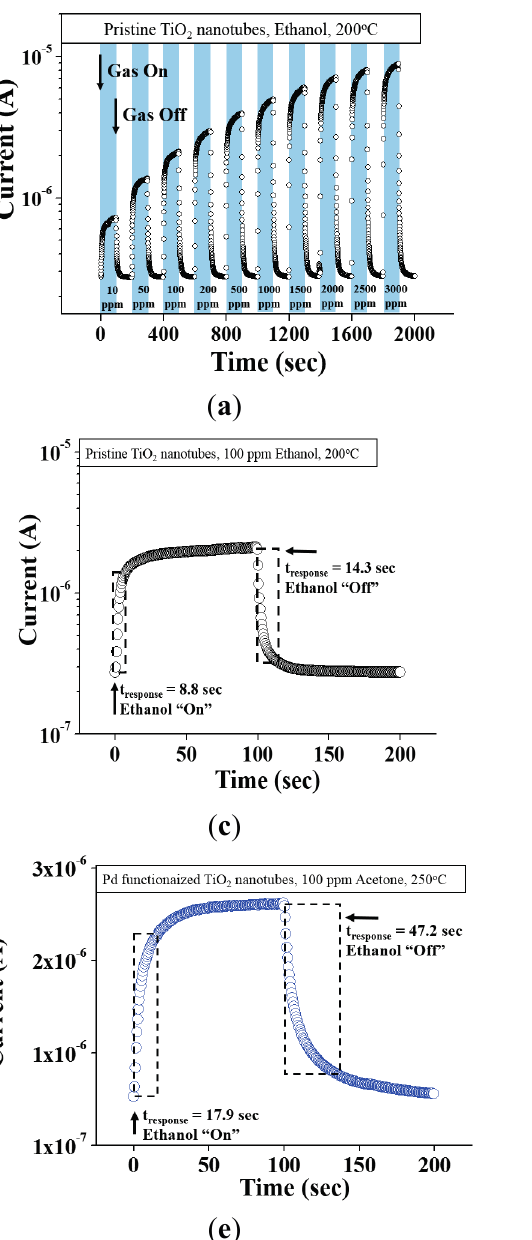
Figure 2. Electrical responses of the gas sensors fabricated from ( a ) pristine TiO nanotubes and ( b ) Pd-functionalized TiO nanotubes to 10–3000 ppm C 2 ( c ) Enlarged part of the pristine TiO nanotube curve in Figure 2a at 100 ppm C 2 ( d ) Enlarged part of the Pd-functionalized nanotube curve in Figure 2b at 100 ppm H OH at 200 °C; ( e ) Electrical response of pristine TiO C 2 5 CH COCH at 250 °C; ( f ) Electrical response of Pd-functionalized TiO 3 3 100 ppm CH COCH at 250 °C. Note: The sensing test temperature for C 3 3 from that for CH COCH 3 3